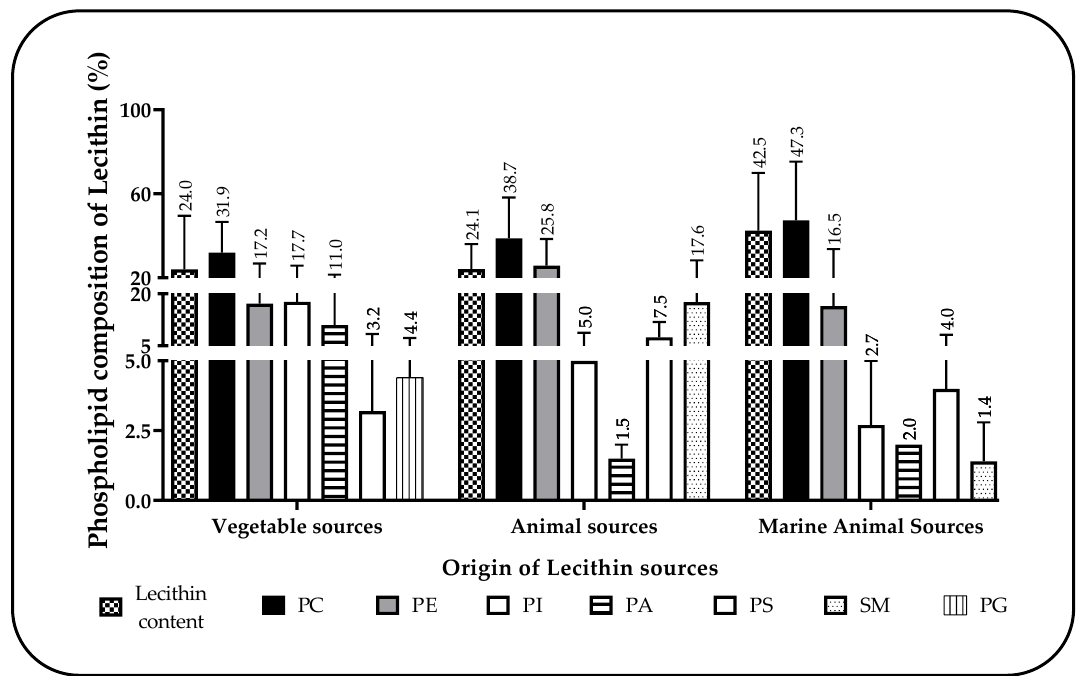
Figure 3. Average composition of phospholipids depending on the origin (lecithin content: fraction of polar lipids in the studied source, PC: Phosphatidylcholine, PE: Phosphatidylethanolamine, PI: Phosphatidylinositol, PA: Phosphatidic acid, PS: Phosphatidylserine, SM: Sphingomyelin, PG: Phosphatidylglycerol).